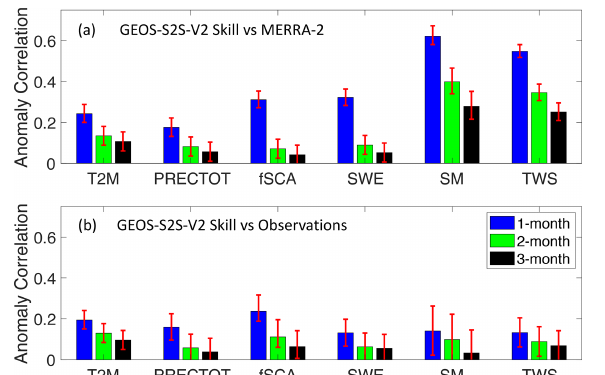
Figure 2. Anomaly correlation skill between variables for the GEOS-S2S forecasts when evaluated against MERRA-2 (a) and against reference data products (b) . The evaluation of the 1-month- lead forecasts is shown in the first bar (blue), the evaluation of the 2-month-lead forecasts is shown in the second bar (green), and the evaluation of the 3-month-lead forecasts is shown in the third bar (black). The red error bars indicate the spatial standard deviation of the anomaly correlation for each variable. The reference data that are used in Figure 2B are listed in Table